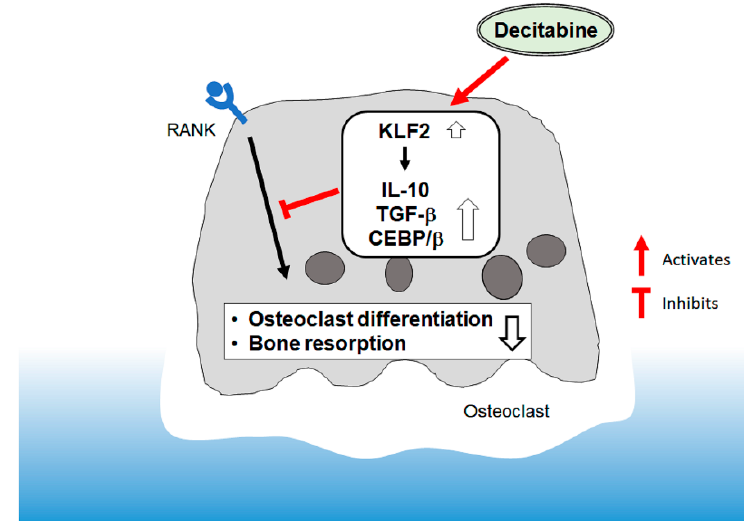
Figure 6. Schematic figure illustrating the possible mechanisms underlying the inhibitory action of decitabine on osteoclast differentiation.